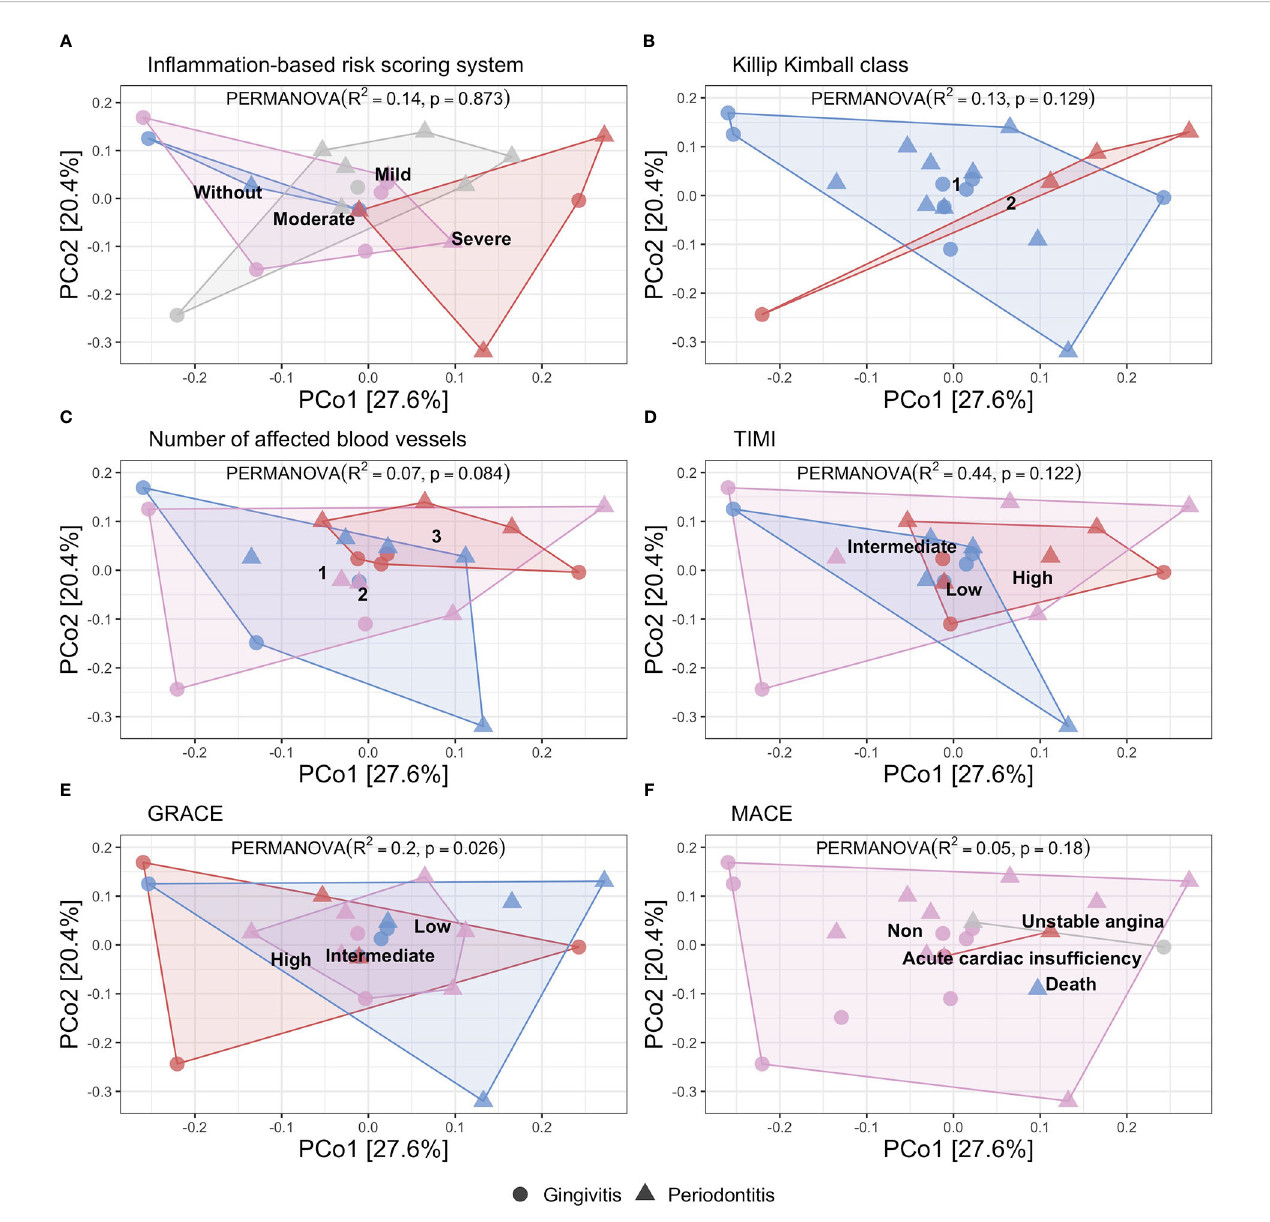
FIGURE 1 Principal coordinate analysis of beta diversity by Bray Curtis index related to different risk score in STEMI patients showed by periodontal disease. (PERMANOVA, R2, p value). (A) In fl ammation-based risk scoring system: Without risk (blue), Mild risk (gray), Moderate risk (pink), and, Severe risk (red) (R 2 = 0.14, p=0.873). (B) Killip Kimball class 1: patients without clinical signs of heart failure (blue), class 2: mild heart failure (red) (R 2 = 0.13, p=0.129). (C) Number of affected blood vessels: one (blue), two (pink), and three (red) blood vessels affected (R 2 = 0.07, p=0.084). (D) Thrombolysis in myocardial infarction score (TIMI): low (blue), intermediate (pink), high (red) (R 2 = 0.44, p=0.122). (E) GRACE score: low (blue), intermediate (pink), high (red) (R 2 = 0.20, p=0.026). (F) Mayor adverse cardiovascular event (MACE): unstable angina (gray), acute coronary insuf fi ciency (red), death (blue), non-MACE (pink) (R 2 = 0.05,